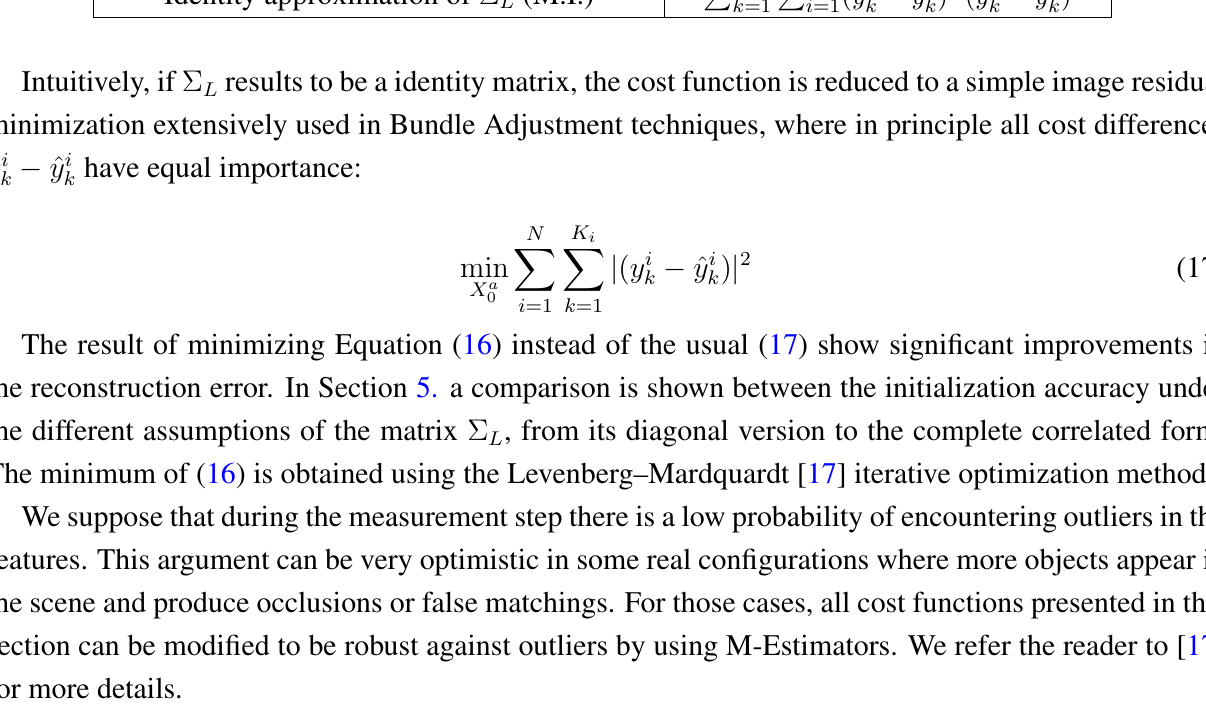
Table 1. Different cost functions depending on the approximations of Σ Type of Approximation cost